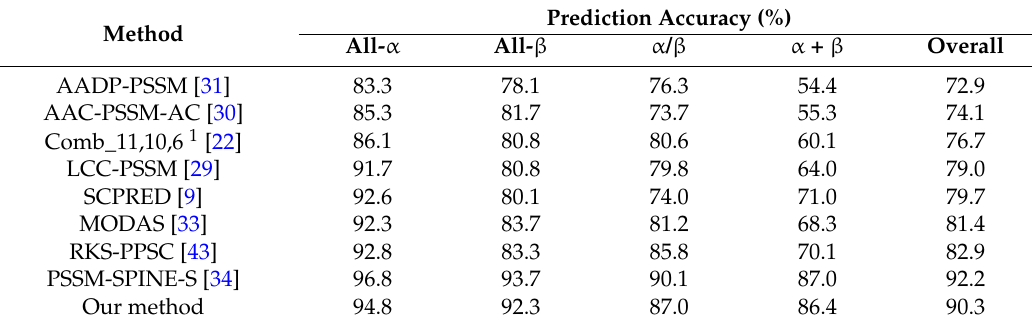
Table 5. Performance comparison of different methods on the 25PDB